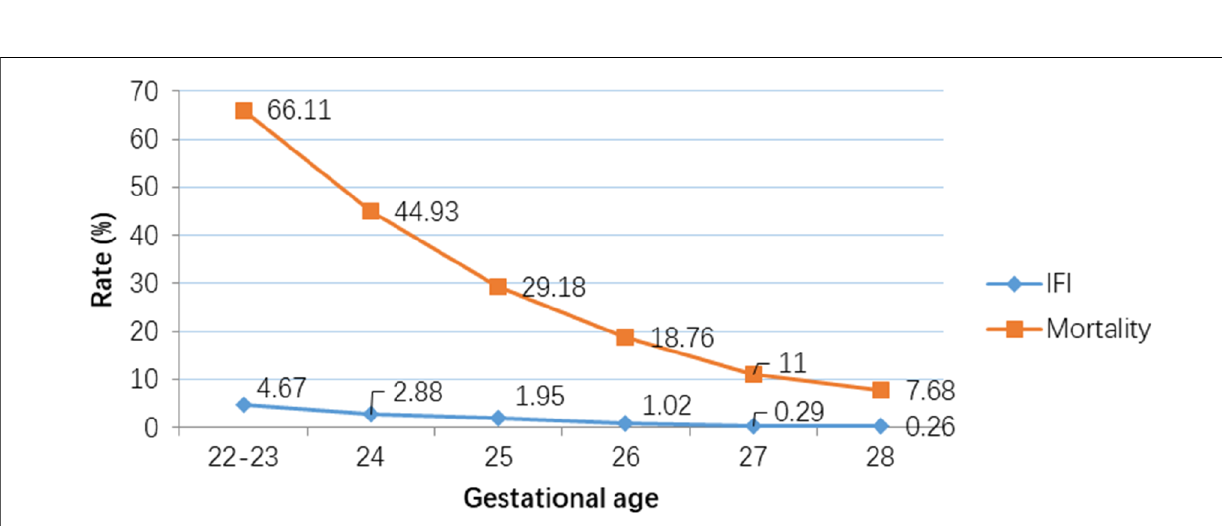
FIGURE 3 Decreasing rates of Invasive Fungal Infection (IFI) and mortality with increasing gestational age. (Armitage trend test: p